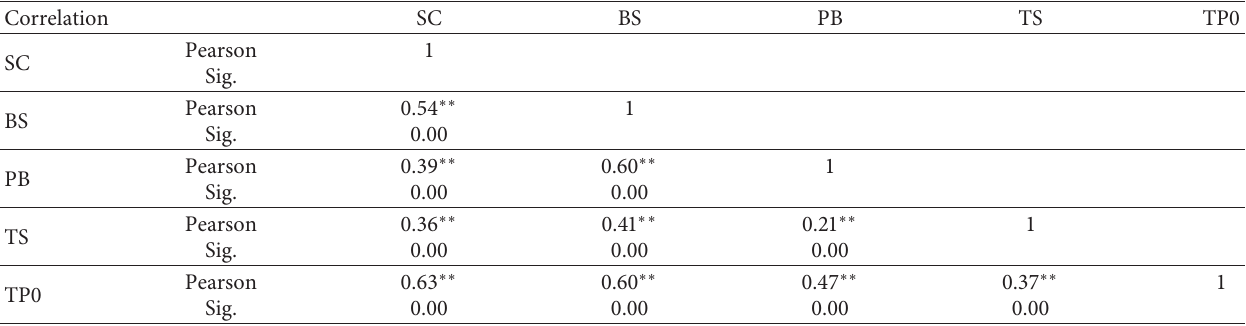
Figure 2: KDE crash density functions in different bandwidths. (a) KDE crash density function for bandwidth � 100m. (b) KDE crash density function for bandwidth � 200 m. (c) KDE crash density function for bandwidth � 500m. (d) KDE crash density function per km for bandwidth � 100m. (e) KDE crash density function per km for bandwidth � 200m. (f) KDE crash density function per km for bandwidth � Table 2: Pearson correlation coefficients.